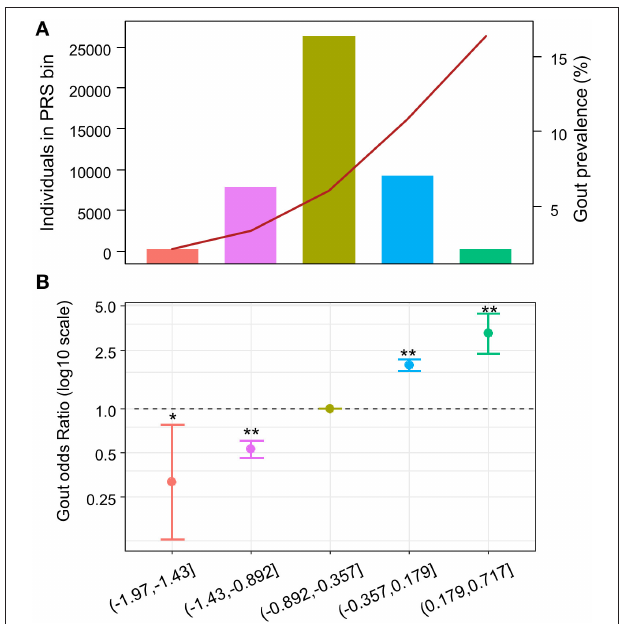
FIGURE 3 | Odds ratio across polygenic risk score (PRS) quintiles. X-axis indicates the PRS quintile. (A) Number and gout prevalence across urate-PRS quintiles in 44,062 unrelated participants of European ancestry. Bar plot and left y-axis indicate the number of individuals in each bin; line plot and right y-axis indicate the gout prevalence. (B) Age, sex, and BMI-adjusted OR of gout (y-axis) across PRS quintiles. The third quintile was used as reference. The dots indicate mean OR; the bars indicate the 95% CI. * p < 0.05, ** p < 5e − 10.